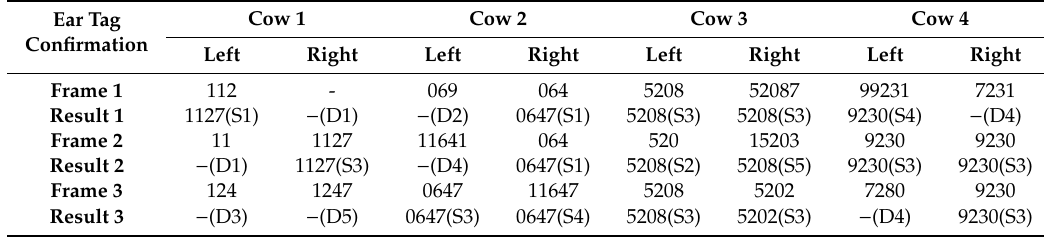
Table 2. Brief illustration of the ear tag confirmation